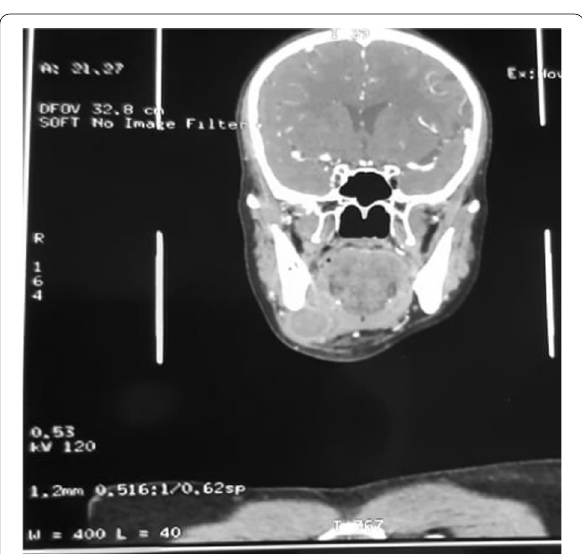
Fig. 2 Preoperative CT scan outlining a mass in the submandibular